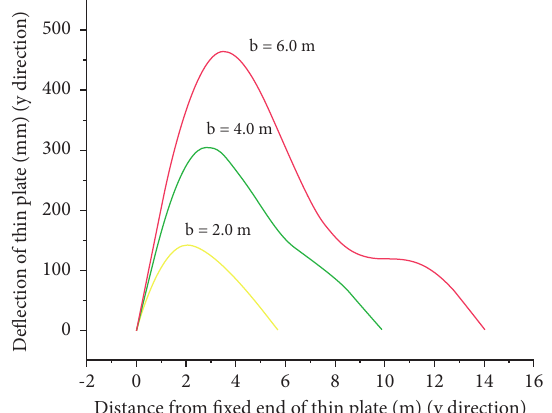
Figure 6: The change curve of roof deflection at different un- supported roof distances.